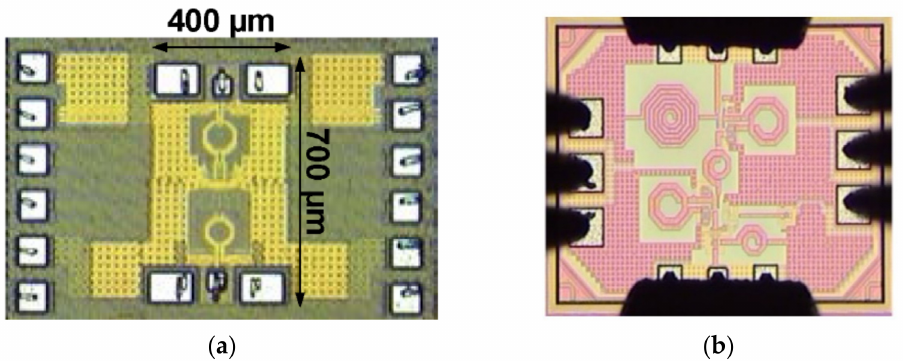
Figure 12. ( a ) 1-Stage 2-stack PA in 28 nm CMOS [59], ( b ) 3-stack PA in 90 nm CMOS [61].